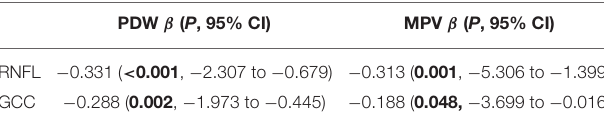
TABLE 5 | Multiple linear regression analysis of platelet parameters and optical coherence tomography (OCT) parameters in POAG. PDW β ( P , 95%